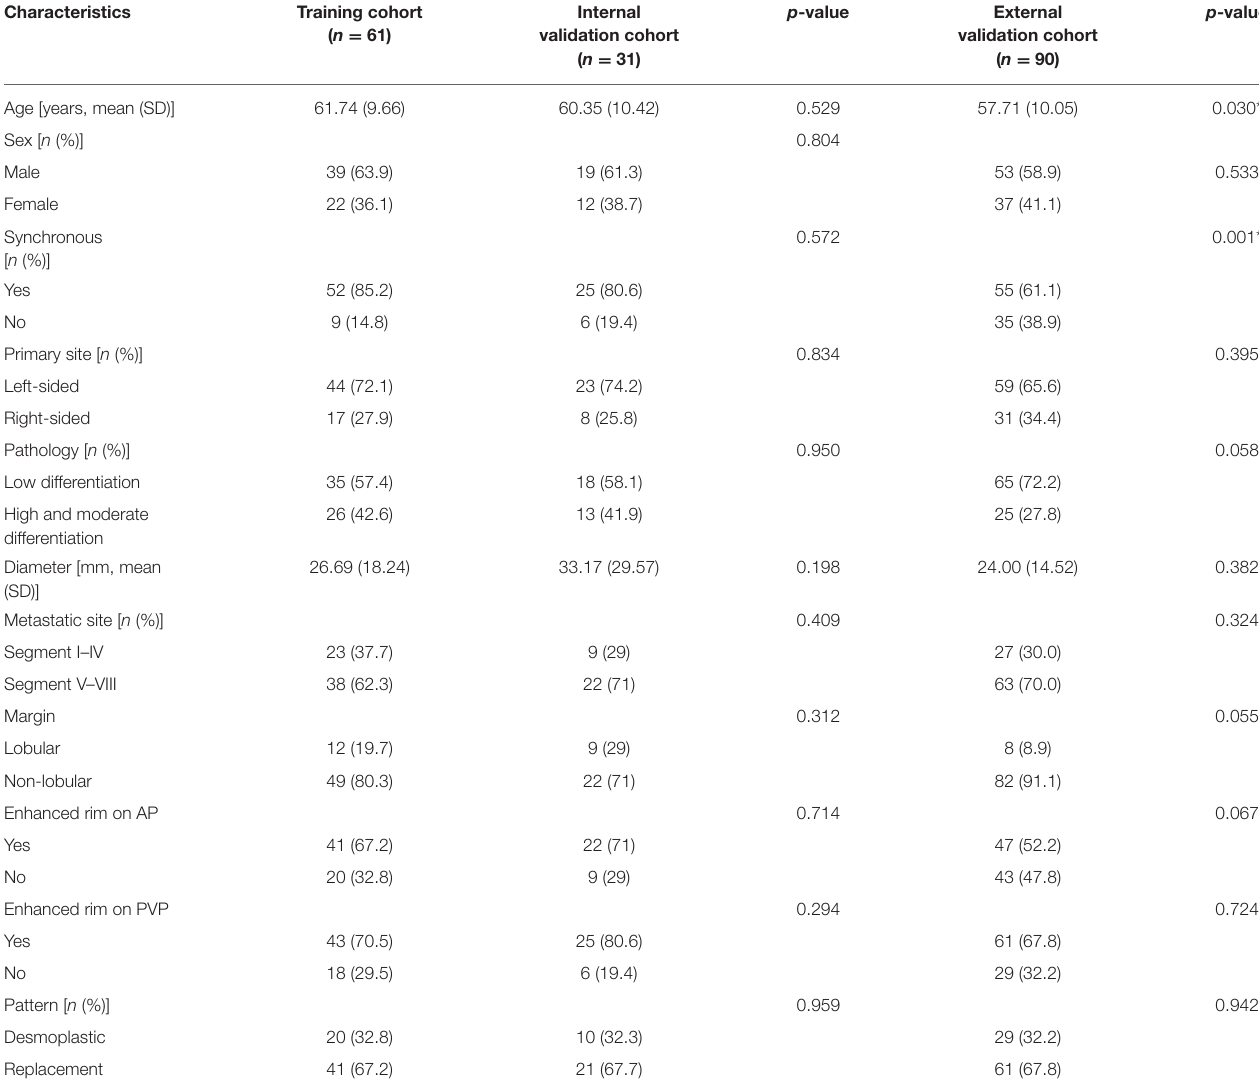
TABLE 1 | Demographics of